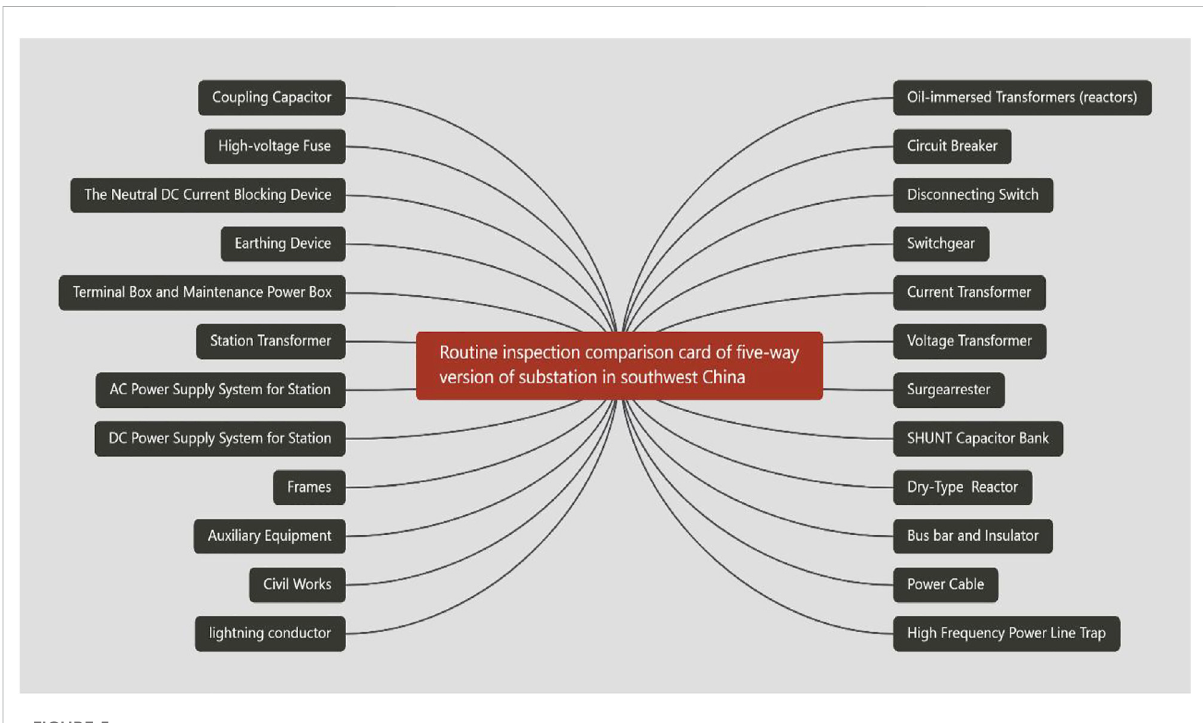
FIGURE 5 Comparison card of routine inspection, video inspection and robot inspection of a substation in Southwest